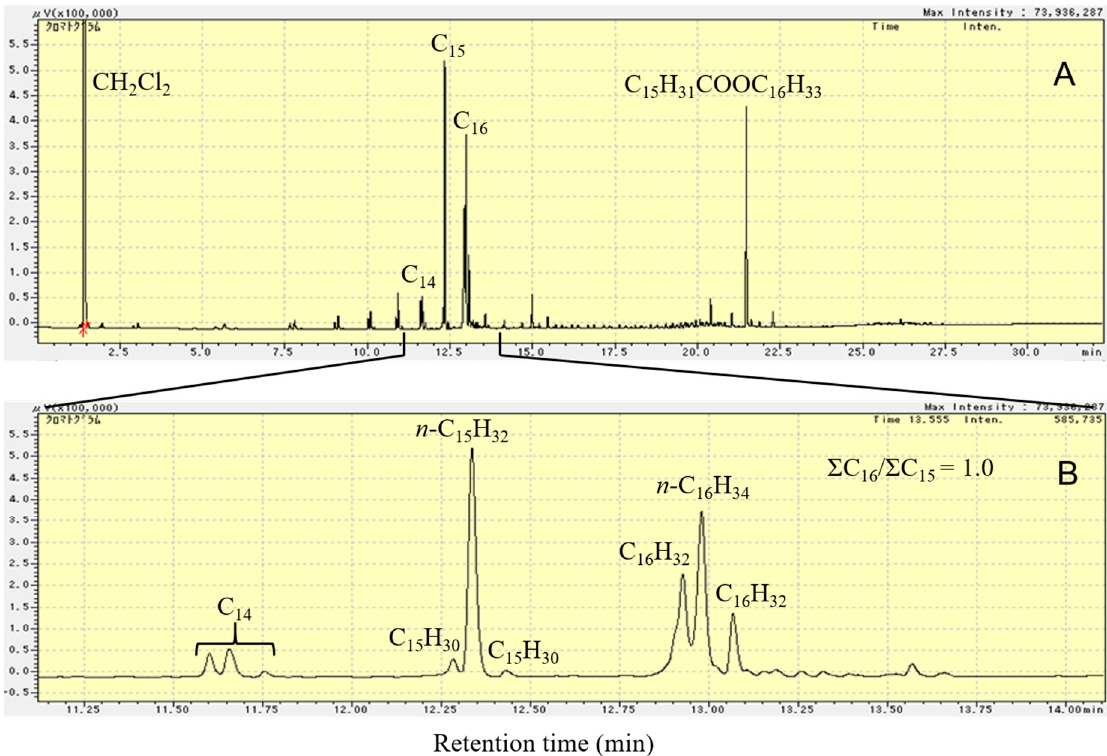
Figure 8. The FID-GC charts of the liquid product formed by deoxygenation of C 15 H 31 COOC 16 H 33 in N 2 atmosphere at 300 ◦ C for 2 h over 1 wt.% Pd/Mg(Al)O catalyst. ( A ): retention time from 0 to 32 min, ( B ): retention time from 11.1 to 14.1 min. Reaction conditions: C 15 H 31 COOC 16 H 33 : 5 g; catalyst: 0.2 g; N 2 pressure at 25 ◦ C: 0.9 MPa.